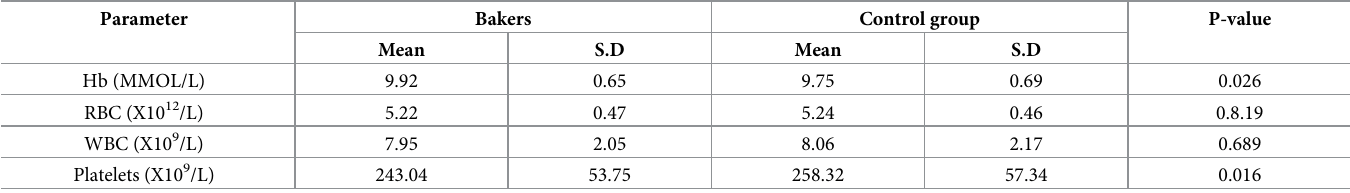
Table 1. Hematological parameters among the bakers and the control